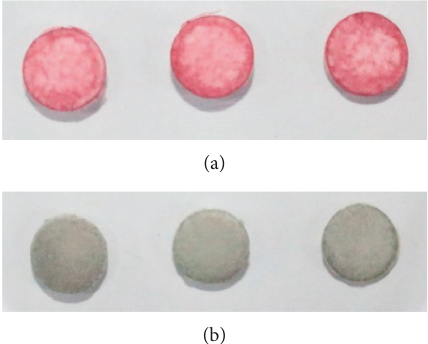
Figure 7: (a) Photographic image of the Whatman paper added with PEI-AuNP solution and dried. (b) Photographic image of the Whatman paper added with 0.1ppm · Hg 2+ ion